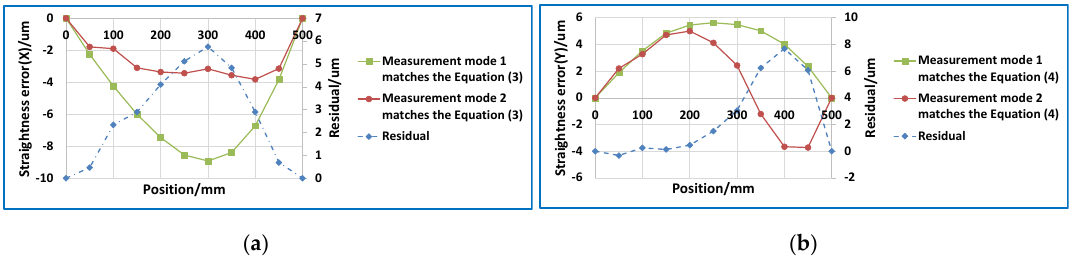
Figure 6. Differences between straightness error measurement models under two measurement Figure 6. Di ff erences between straightness error measurement models under two measurement modes. modes. ( a ) Straightness error (X); ( b ) Straightness error (Y). ( a ) Straightness error (X); ( b ) Straightness error